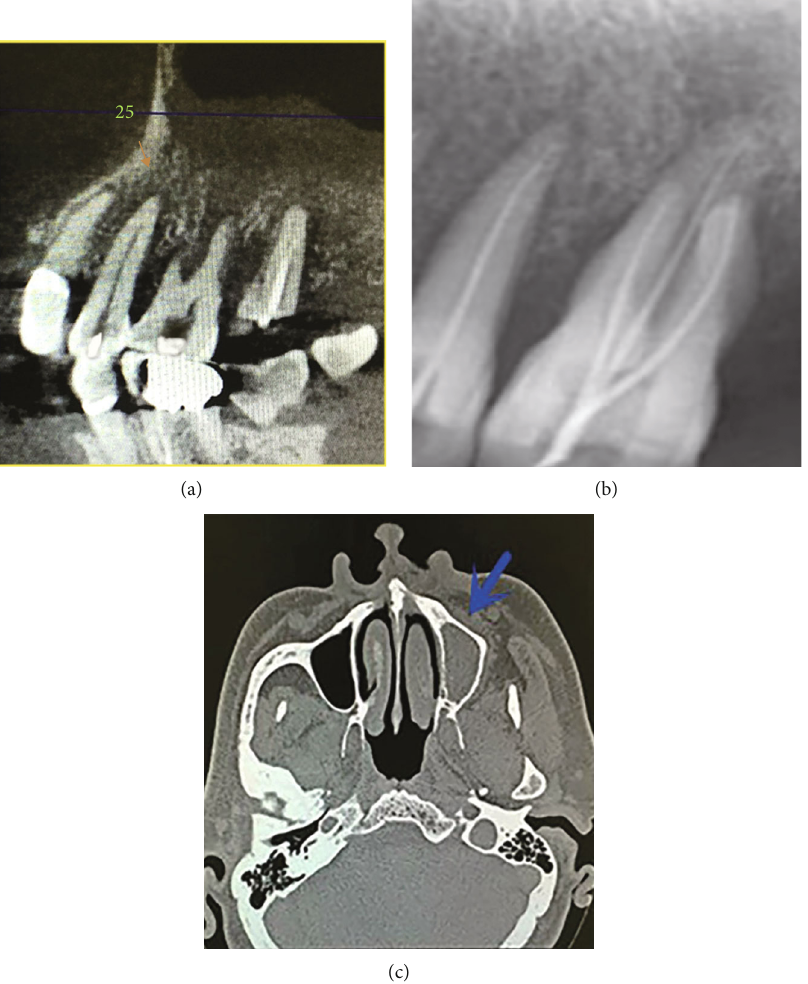
Figure 1: CBCT images showed multiple low-attenuating entities apical to premolars and the fi rst molar. An extensive soft tissue mass was identi fi ed in the left maxillary sinus which extended through the medial maxillary sinus wall (a). Dental X-ray image showed appropriate root canal therapy (b). Transverse CT image showed maxillary sinus full of substantial objects which destroyed multiple walls